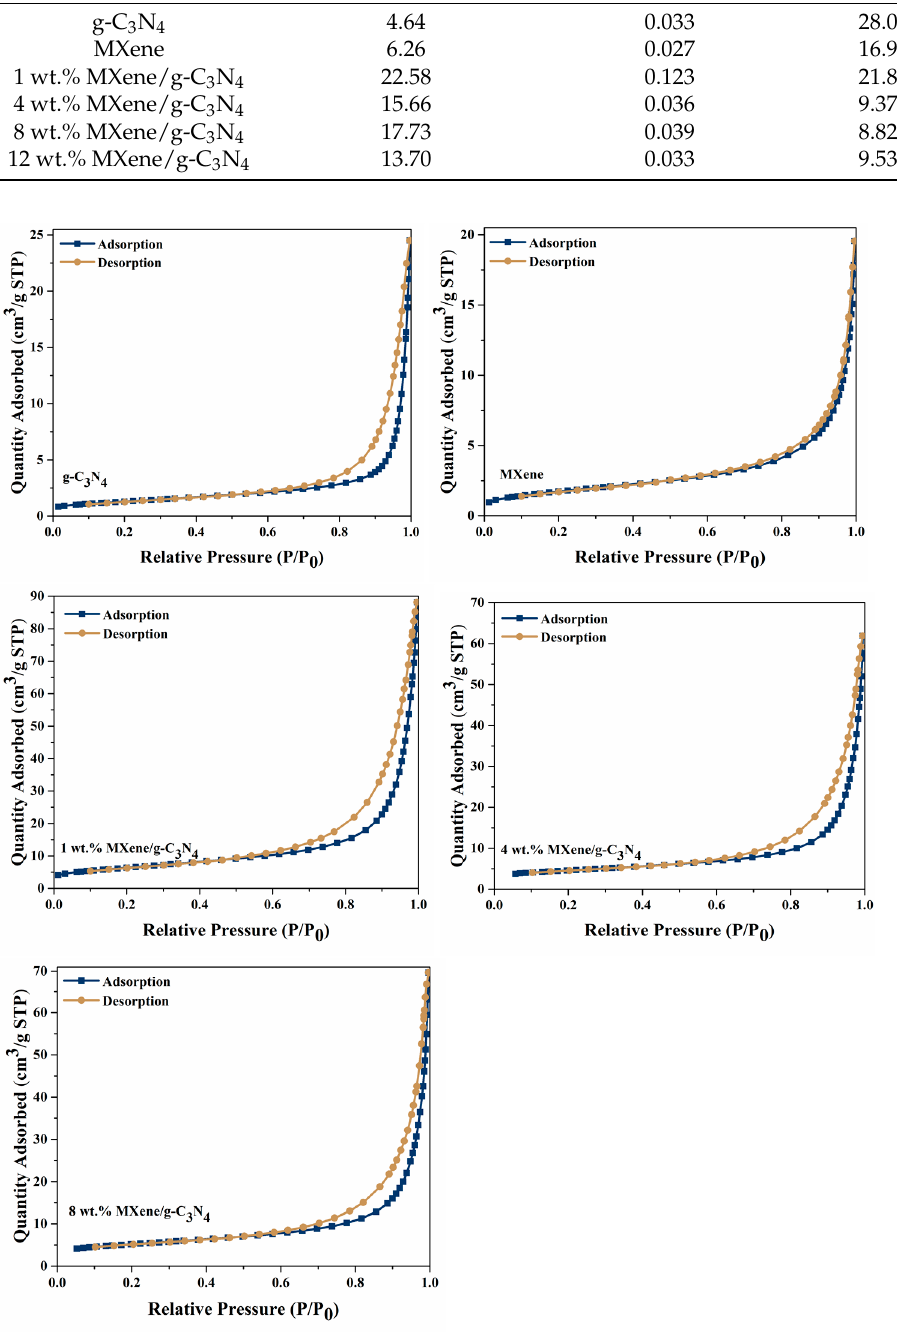
Figure 6. Nitrogen adsorption–desorption isotherms of the as-synthesized MXene/g-C 3 N 4 heterostructure photocatalysts.